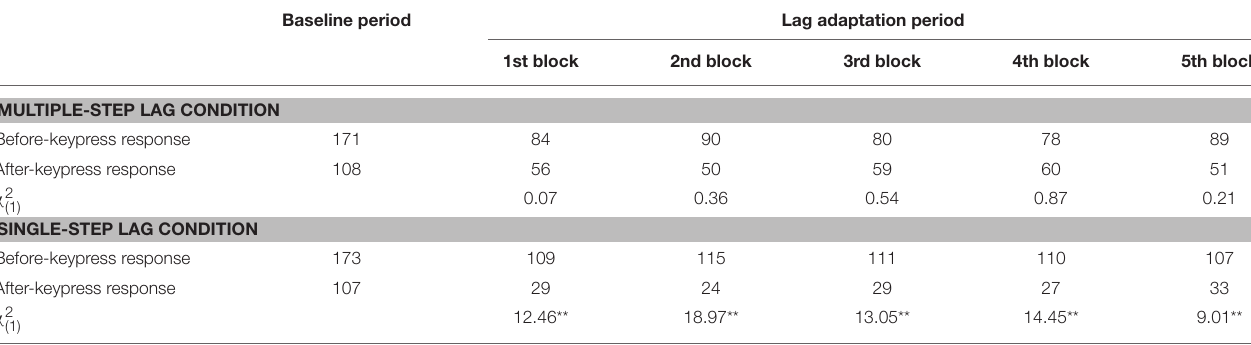
TABLE 1 | Results of TOJ task in Experiment